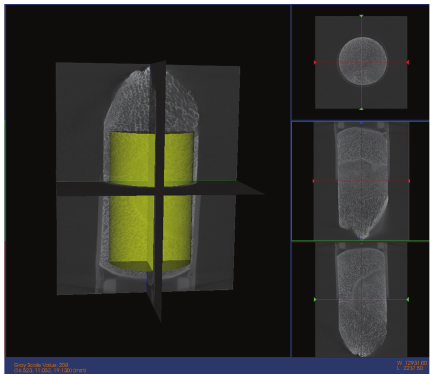
Figure 3: Micro-CT scan of a sample bone specimen. The yellow cylinder is the region of interest for extracting bone mineral parameters. The size of the ROI is kept constant in the longitudinal study for each specimen. The ROI is located at approximately the same position to minimize variation.